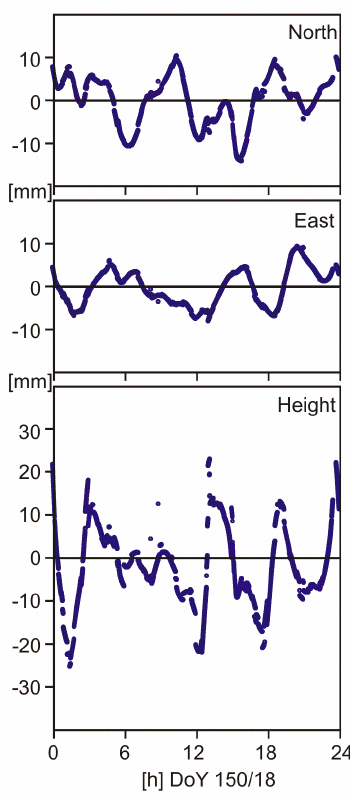
Figure 7. Epoch-by-epoch coordinate errors of station BIK0 (Bishkek, Kyrgyzstan) on DoY 150/18 due to L2 quarter cycle biases: ionosphere-free linear combination with ambiguities being fixed, estimation of tropospheric zenith delays enabled.